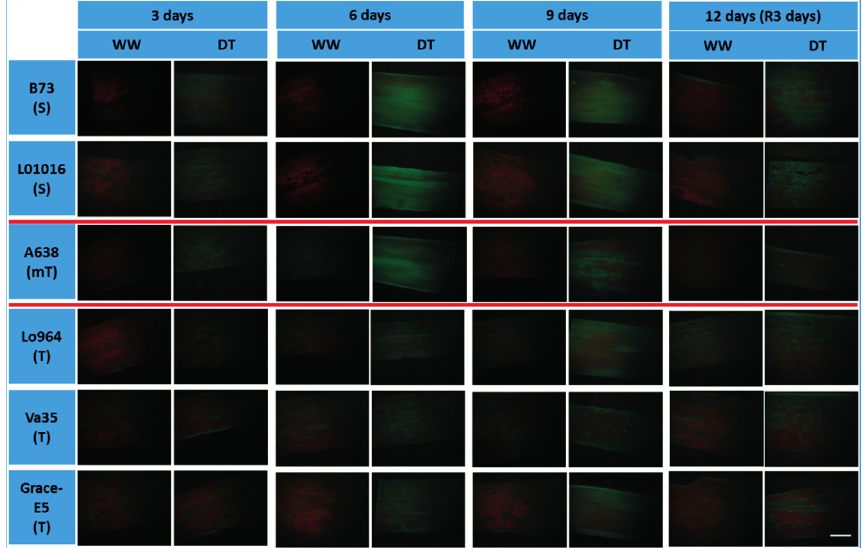
Figure 5. Visualization of nitric oxide (NO) in maize leaf tissues subjected to drought stress. Endogenous NO levels was monitored in maize leaves by staining NO using DAF-FM diacetate, and displayed by green fluorescence; the red fluorescence represents the chlorophyll intensity. WW refers to well-watered leaves; DT refers to drought treated leaves of all tested maize genotypes. Scale bar, 5